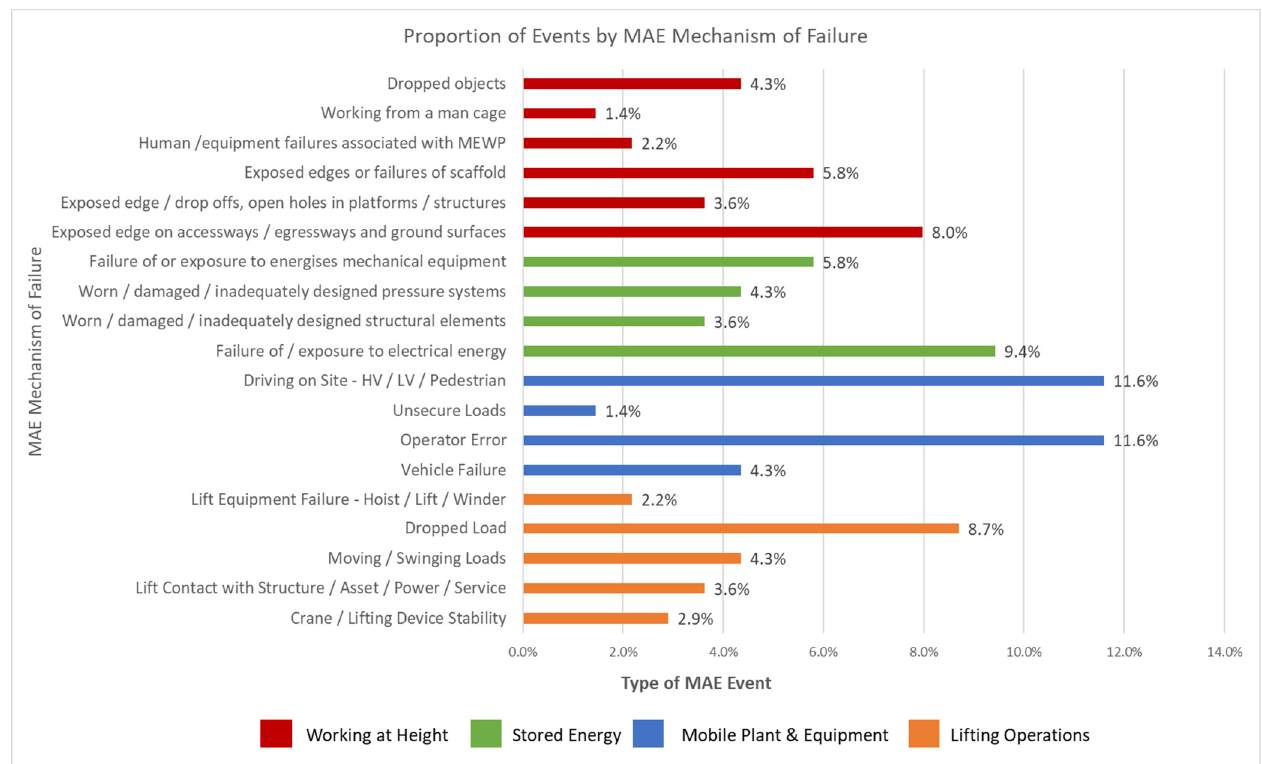
Figure 4. Proportion of events by MAE hazard.